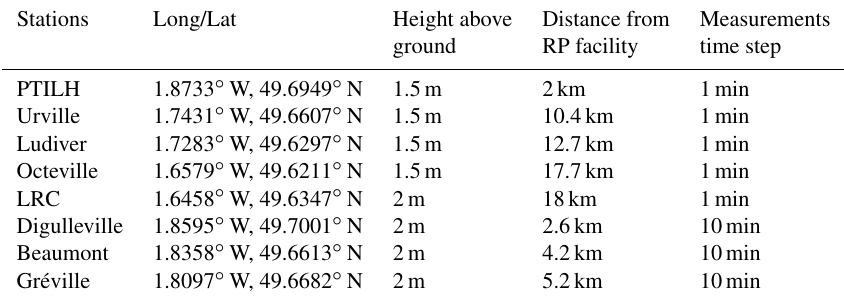
Table 1. Description of the 8 localizations of 85 Kr air concentration measurement stations used in this article. Stations Long/Lat Height above Distance from Measurements ground RP facility time step PTILH 1.8733 ◦ W, 49.6949 ◦ N 1.5m 2km 1min Urville 1.7431 ◦ W, 49.6607 ◦ N 1.5m 10.4km 1min Ludiver 1.7283 ◦ W, 49.6297 ◦ N 1.5m 12.7km 1min Octeville 1.6579 ◦ W, 49.6211 ◦ N 1.5m 17.7km 1min LRC 1.6458 ◦ W, 49.6347 ◦ N Digulleville 1.8595 ◦ W, 49.7001 ◦ N Beaumont 1.8358 ◦ W, 49.6613 ◦ N